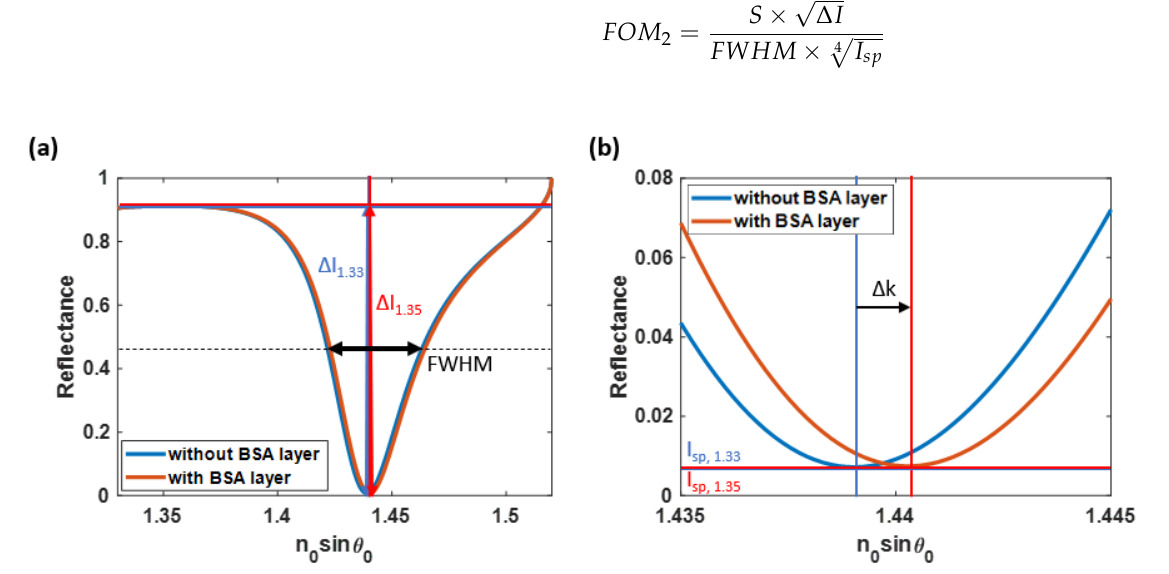
Figure 5. The calculation procedures of the discussed quantitative performance parameters for the ideal uniform gold surface sensor, including ( a ) ∆ I , FWHM , ( b ) S , and I sp